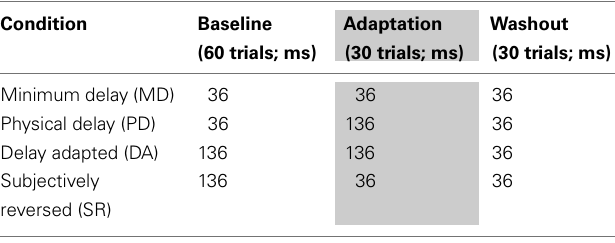
Table 1 | Feedback delays ( ∆ t feedback ) used for the minimum delay and delay adaptation conditions.